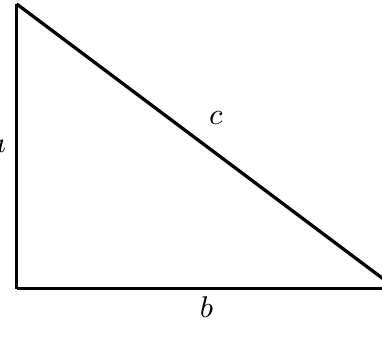
Figure 3. Congruent